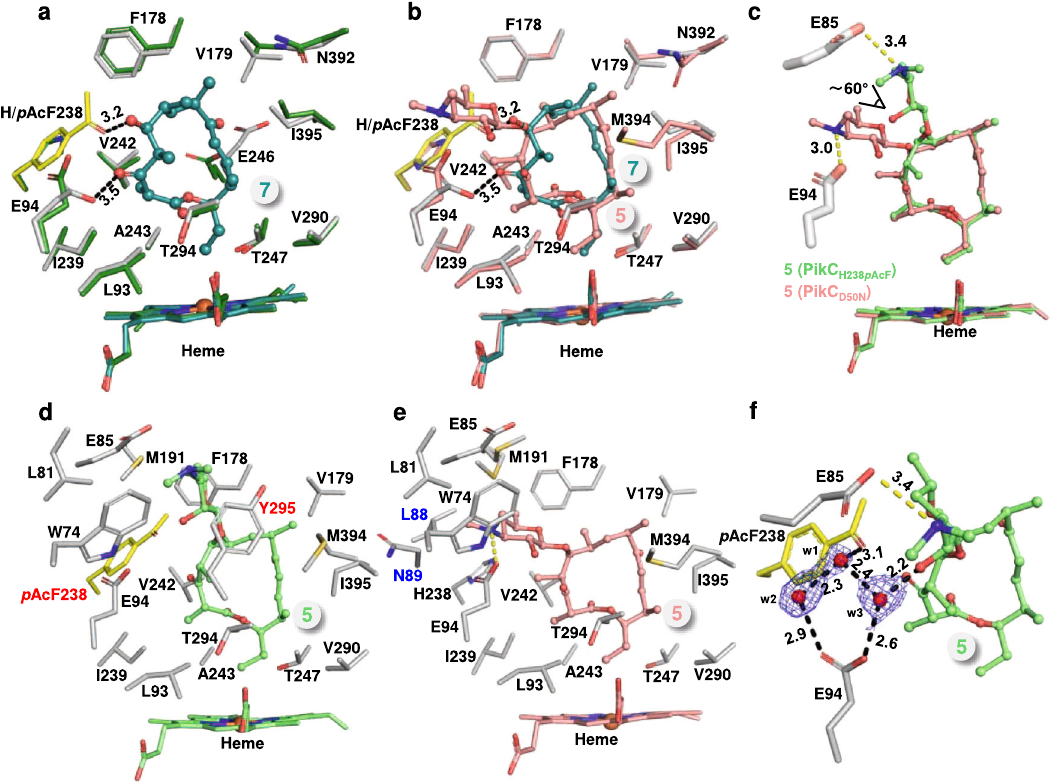
Fig.5|Structuralanalysisofnarbonolide(7)-boundandnarbomycin(5)-bound PikC H238 p AcF . a , b Molecular modeling of 7 within the substrate binding pocket of PikC H238 p AcF : comparisons of contacting amino acid side chains around the sub- strate binding site within 4.5Å between 7 -bound PikC H238 p AcF and substrate-free PikC WT ( a ) and 5 -bound PikC D50N ( b ). The side chains are shown as sticks in grey (PikC H238 p AcF ), forest (substrate-free PikC WT ), and salmon ( 5 -bound PikC D50N ). The heme groups are colored consistent with the corresponding substrates. The hydrogen bonds are shown as dashed black line. c Schematic diagram of the positions of 5 in superimposed PikC H238 p AcF and PikC D50N . The salt bridges formed